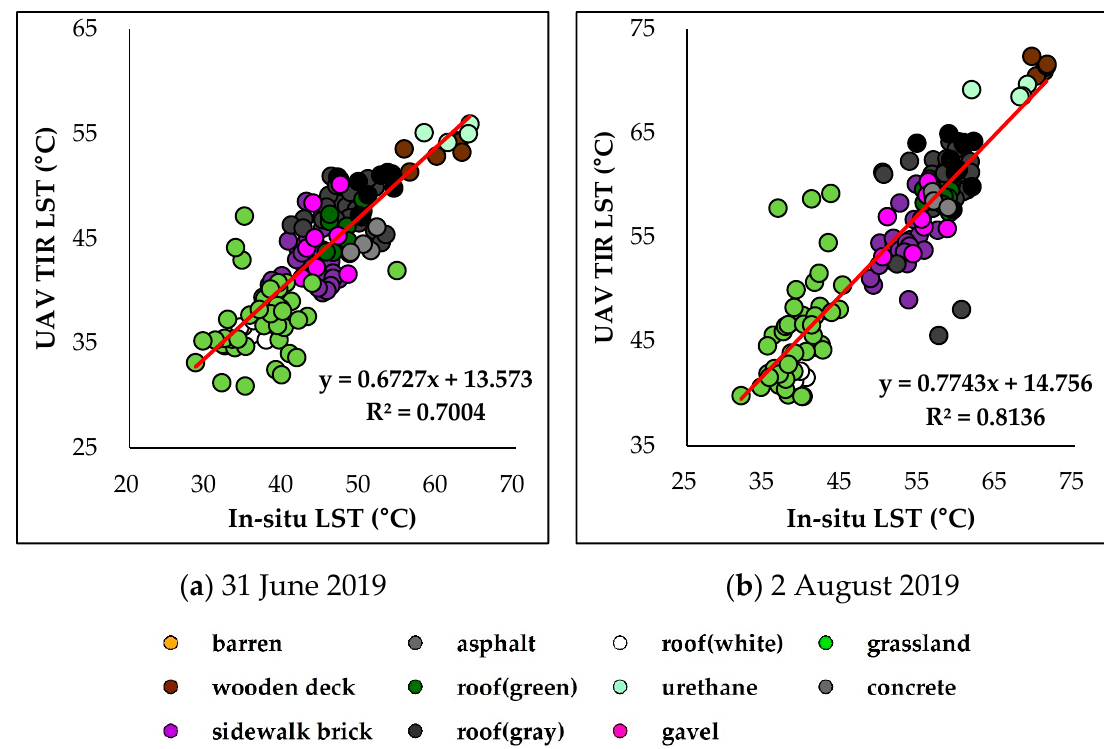
Figure 7. Results of the scatter plot analysis of the in-situ LST and UAV TIR LST. Table 3. RMSE between the in-situ LSTs and UAV TIR LSTs (°C).